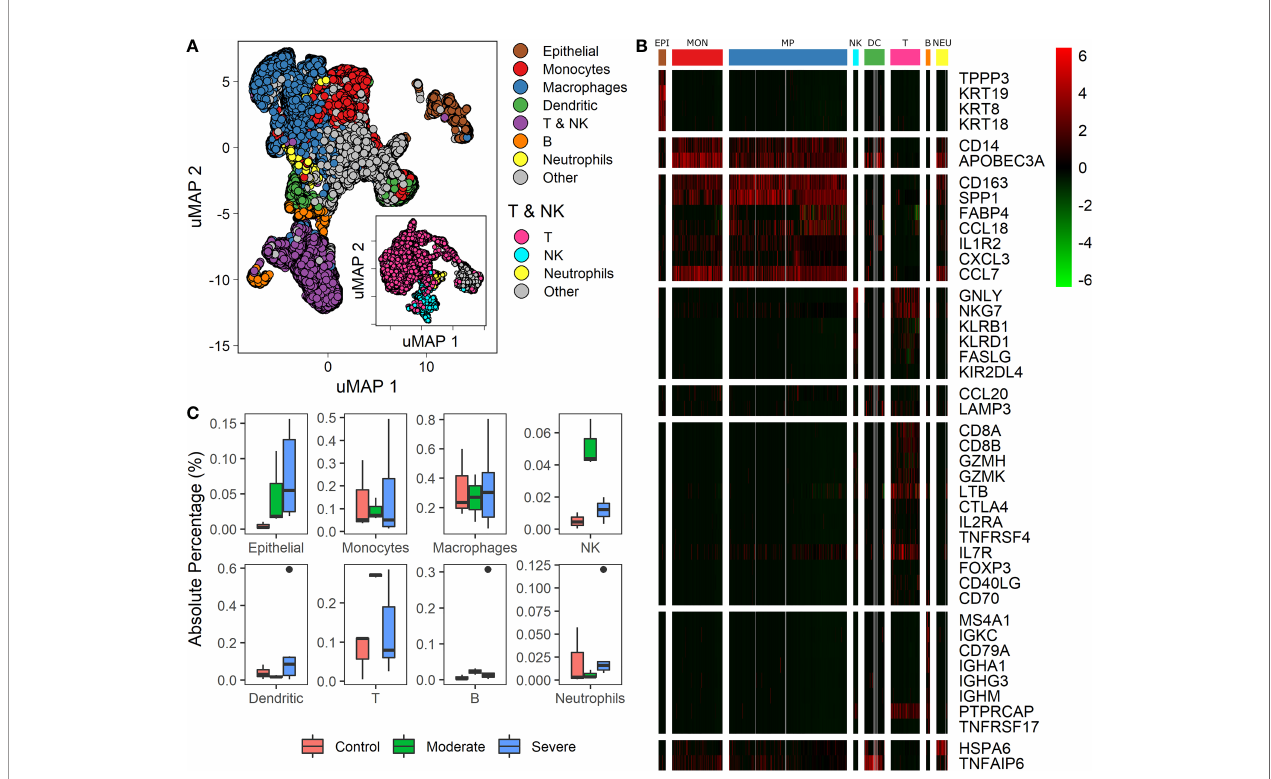
FIGURE 1 | Differences in cell types among patients with diverse infection severity. (A) Umap projection of single cell data showing diverse cell types identi fi ed based on biomarkers ( Table S1 ). The inset shows the uMAP projection and separation for the T & NK group. (B) Heatmap showing differentially expressed genes of clusters (columns) used to identify the cell types (rows): EPI, Epithelial cells; MON, monocytes; MP, macrophages; NK, natural killers cells; DC, dendritic cells; T, T cells; B, B cells; NEU, neutrophils. Rows dividers are related to each cell type, and the column groups set the cluster associated to each cell type. Colorbar shows the genes normalized expression values. (C) Boxplot for every cell-type identi fi ed, proportions of each cell type among healthy controls, moderate and severe